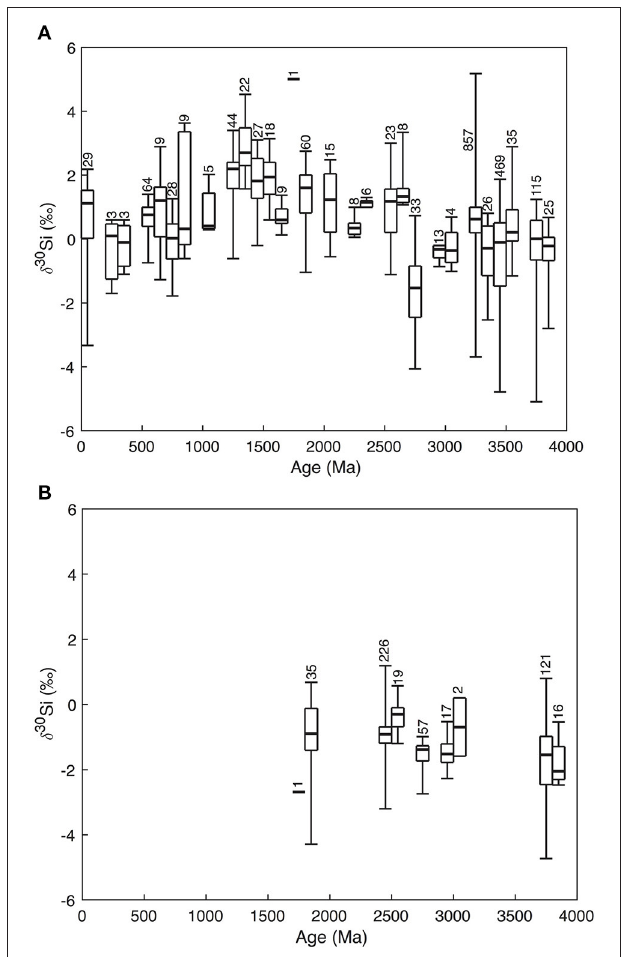
FIGURE 2 | Variations of δ 30 Si in cherts (A) and BIFs (B) with geological age. The data are clustered into 100 My bins. Numbers represent the amount of individual datapoints used in the whisker boxes. Data from André et al. (2006), Robert and Chaussidon (2006), van den Boorn et al. (2007, 2010), Steinhoefel et al. (2009, 2010), Abraham et al. (2011), Heck et al. (2011), Chakrabarti et al. (2012) , Delvigne (2012), Marin-Carbonne et al. (2014), Hu et al. (2013), Ramseyer et al. (2013), Geilert et al. (2014), Li et al. (2014), Brengman (2015), Stefurak et al. (2015), Delvigne et al. (2012), Wen et al. (2016), and Ding et al.